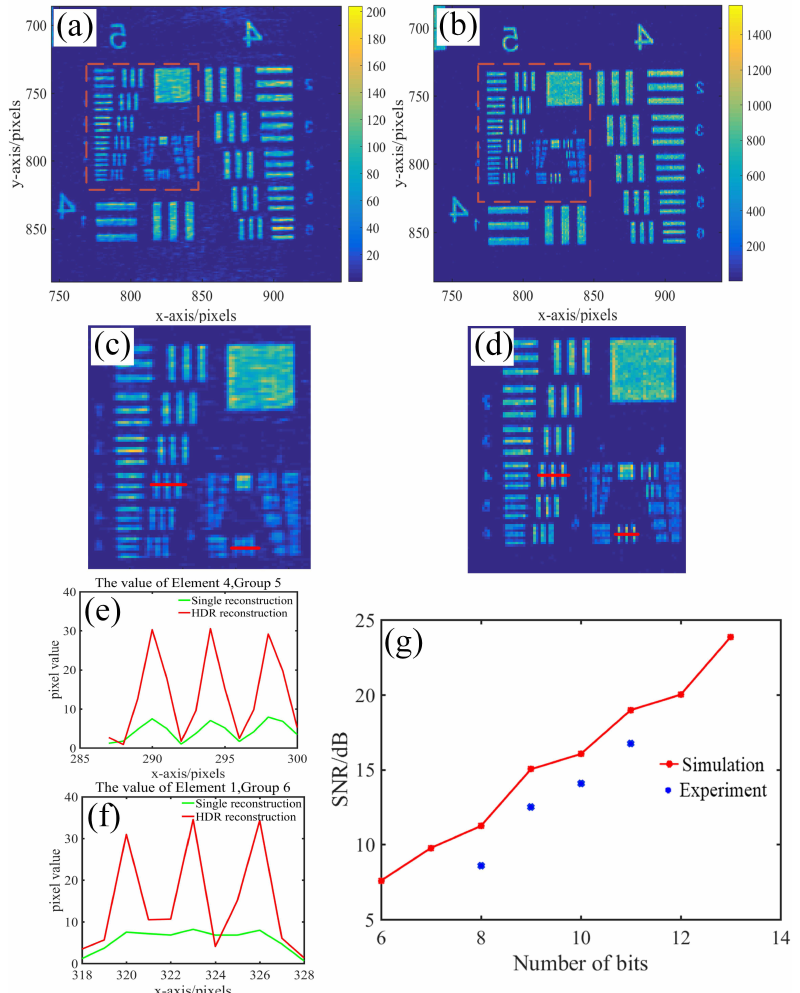
Figure 4. Experiment results. ( a ) Reconstructed image with normal exposure conditions. ( b ) Recon- structed image with HDR method based on multiple diffraction patterns. ( c , d ) are the enlarged areas in the red dashed box of ( a , b ), respectively. ( e ) The intensity profiles of Element 4, Group 5. ( f ) The intensity profiles of Element 1, Group 6. ( g ) The relationship between the enhancement of SNR and the number of bits in simulation and